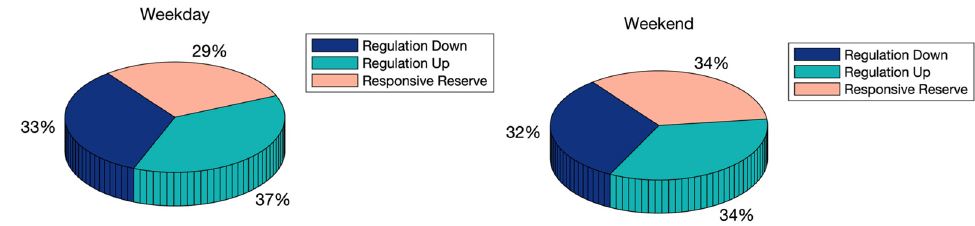
Figure 8. Proportion of regulation and reserve result of Audi e-tron.